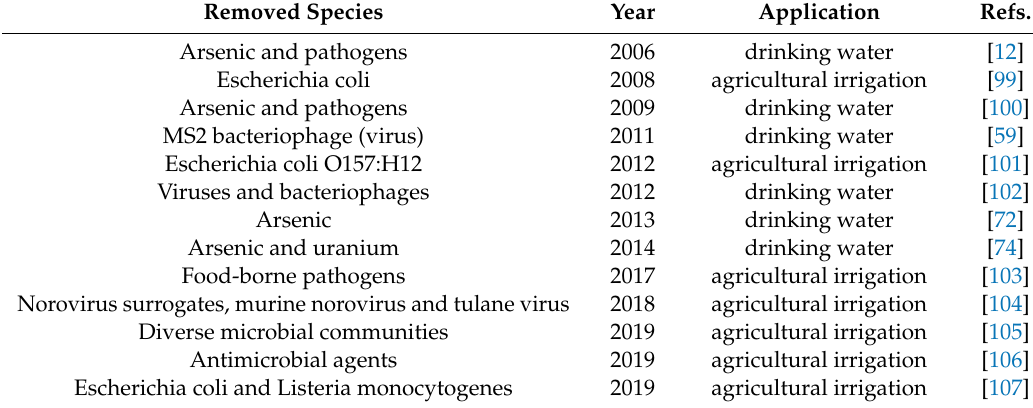
Table 1. Overview of the types of contaminants removed by Fe 0 filters. The selection illustrates the potential of iron filters to remove the most abundant natural pollutants: As, pathogens (bacteria and viruses) and